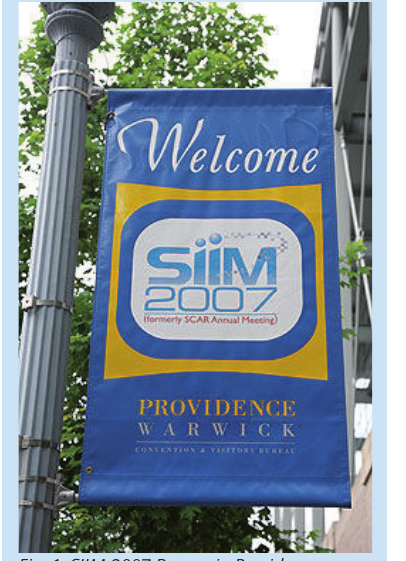
Fig. 1. SIIM 2007 Banner in Providence.